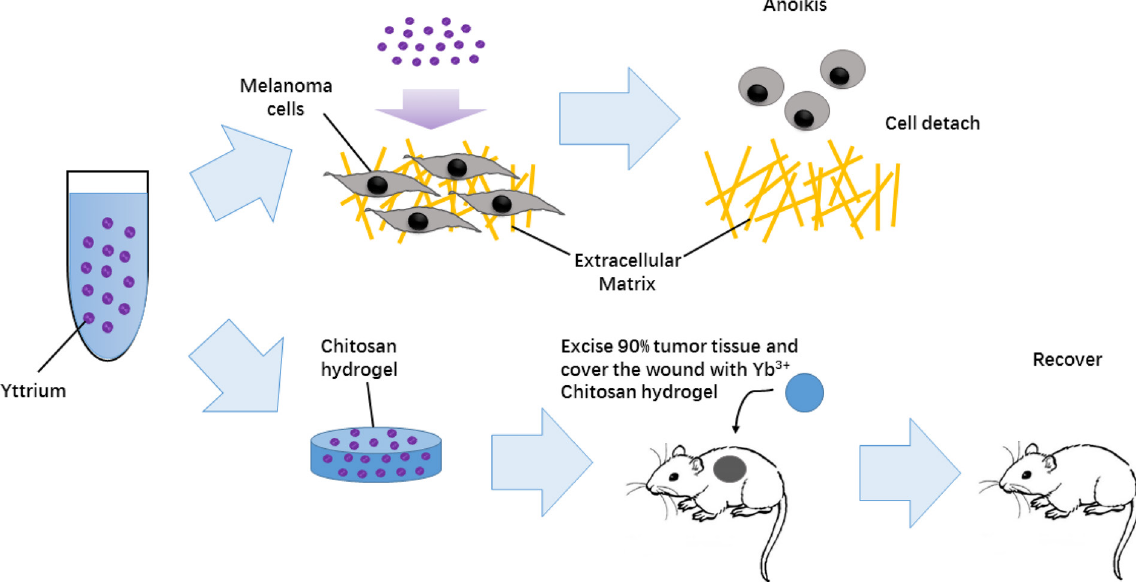
Figure 8: A Yb 3+ -containing chitosan hydrogel (Yb-CS hydrogel) was reported for the first time to inhibit the FAK-dependent signaling pathway and induce cancer cell anoikis. In vivo, our study showed that the Yb-CS hydrogel inhibited the recurrence of melanoma in a mouse bare xenograft tumor